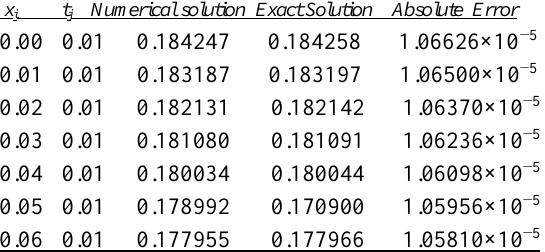
Table 1. Numerical and exact solutions of equation (1) and absolute errors when ∆𝑥 = 0.01 . x i